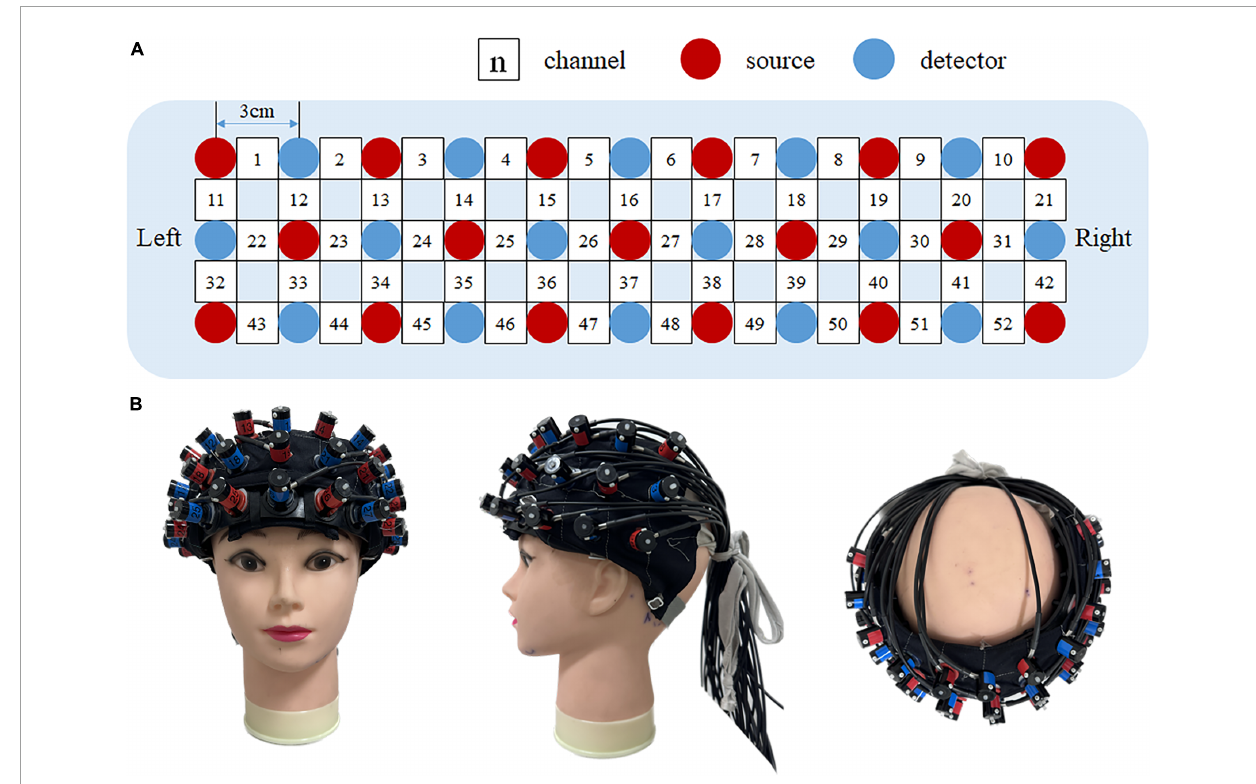
FIGURE2 fNIRS measurement setting. (A) The location of 52 channels and 33 probes. Red dots indicate 17 fNIRS sources, blue dots indicate16 fNIRS detectors, and white squares indicate 52 fNIRS channels. (B) Position of the optode plate on the subject’s forehead. Left to right: anterior view, side view, and top view,